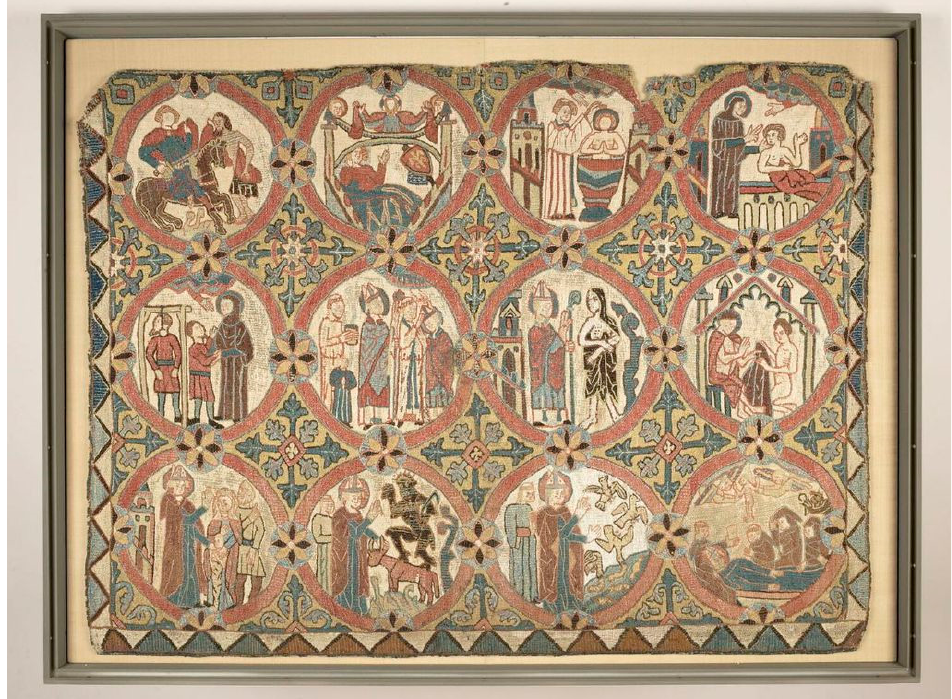
Figure 3. An antependium from Grenjaðarstaðar Church in northern Iceland, now on display in